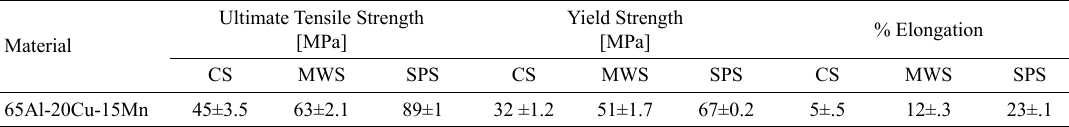
Table 2. Ultimate Tensile Strength, Yield Strength and percentage elongation for 65Al 20Cu-15Mn compositions